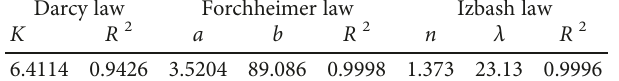
Table 2: Fitted relation parameters of three formulas. Darcy law